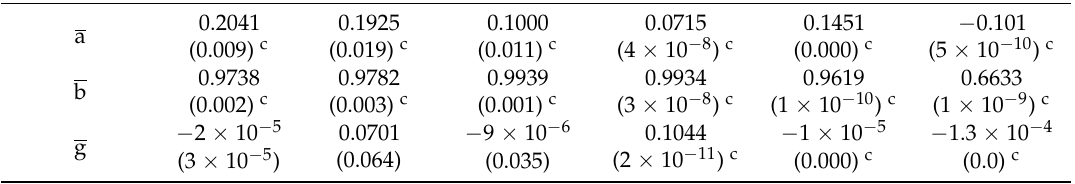
Panel C. The conditional correlation matrix